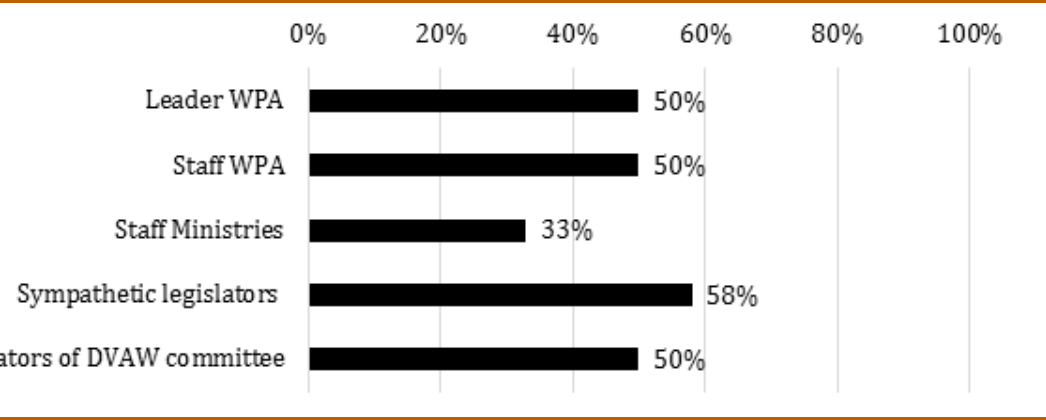
Figure 3: Mechanisms used to in(cid:976)luence the political sphere in Chile